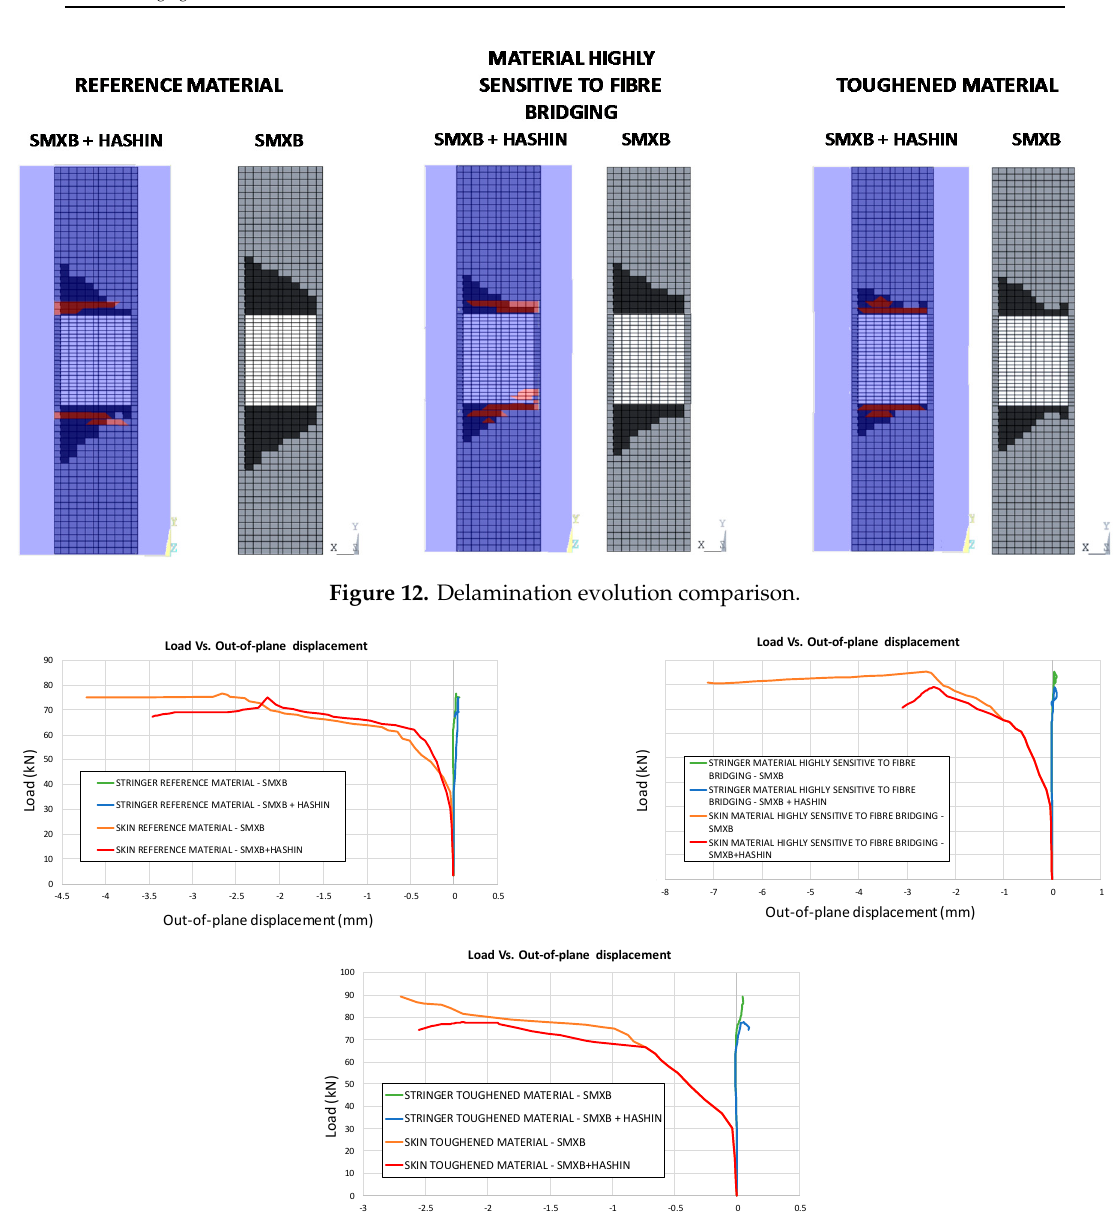
Figure 14. Load vs. Applied displacement comparison. In Figure 15, the load versus displacement curves, related to the three analysed material systems with combined intra-laminar and inter-laminar damage evolution, are shown. From this figure, it is possible to appreciate that the Mode I fracture toughness values do not have a significant influence